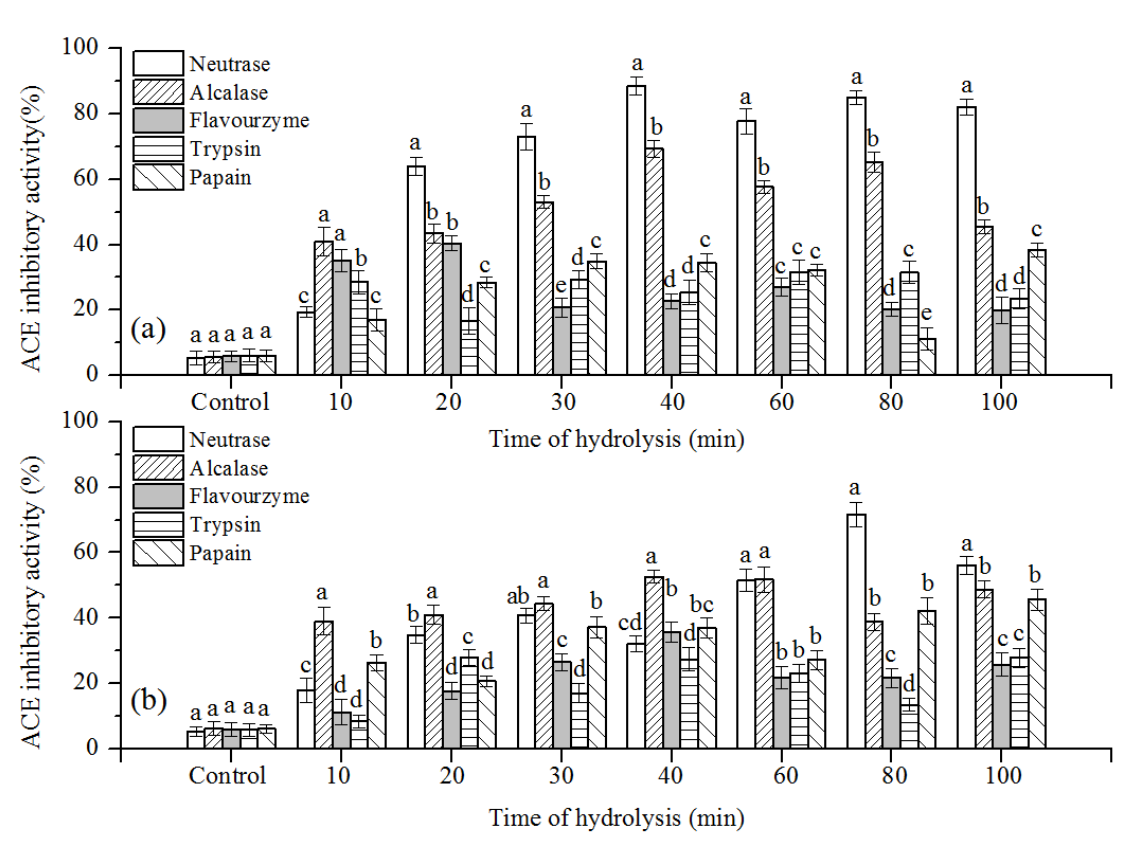
Figure 2. ( a ) Effect of hydrolysis time on the ACE inhibitory activity of CGMHs using different proteases in combination with Protamex; ( b ) Effects of hydrolysis time on the ACE inhibitory activity of CGMHs using different proteases in combination with pancreatin. Significant differences between results are indicated by different letters ( p <